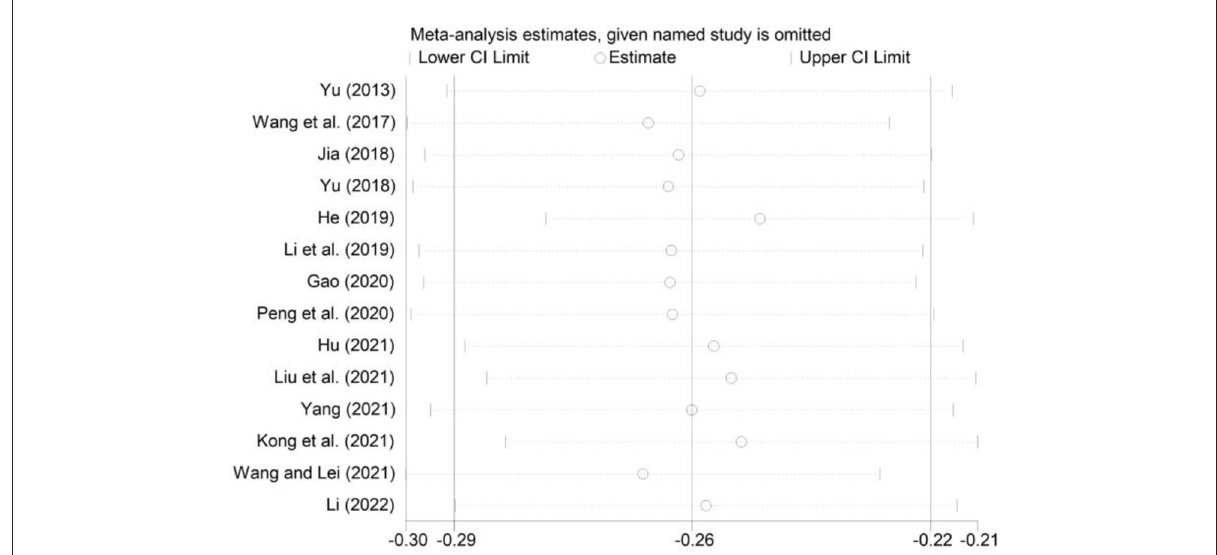
FIGURE5 Sensitivity analysis of the correlation between smartphone addiction and self-esteem.